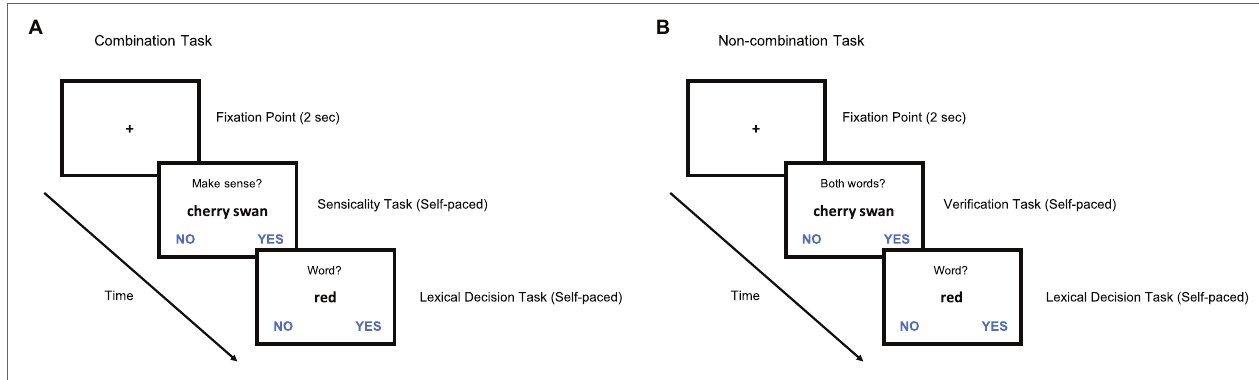
FIGURE 1 | An example trial in Experiment 1 and 2. (A) Combination task condition in Experiments 1 and 2: Participants viewed novel noun–noun compound words and decided whether the given compound was meaningful (sensicality task) followed by the lexical decision task (LDT). (B) Non-combination task condition in Experiment 2: Participants viewed novel noun-noun compound words and decided whether both the modifier and head nouns were words (verification task) followed by LDT.